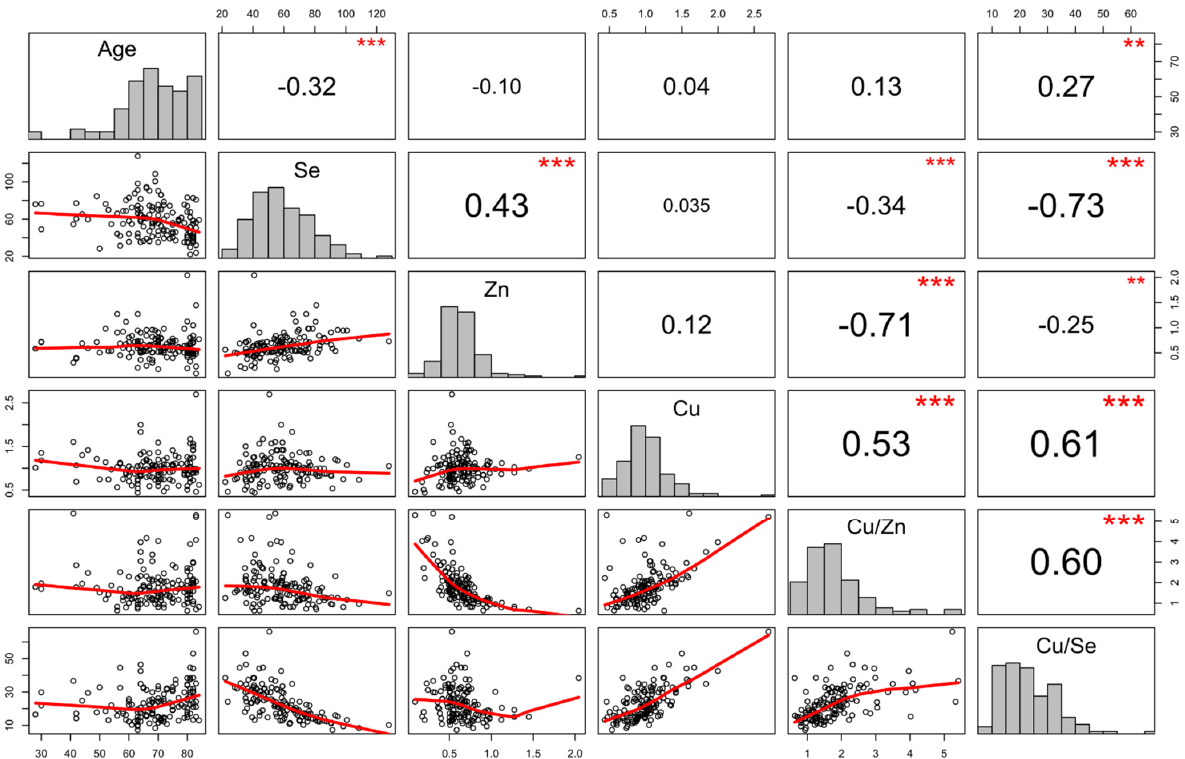
Figure 1. Spearman’s rank-order correlation matrix with scatterplots for serum TEs and molar ratio levels of these elements in the patients with acute ischemic stroke. p -values < 0.05 were considered statistically significant; * p < 0.05 ** p < 0.01, *** p < 0.001.